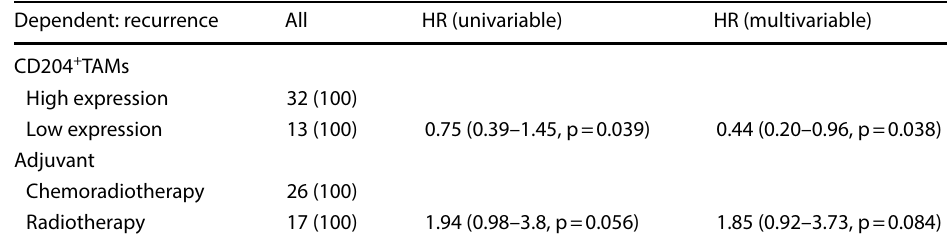
Table 7 Relationship between CD204 + TAMs and RFI in glioblastoma patients receiving chemoradiotherapy